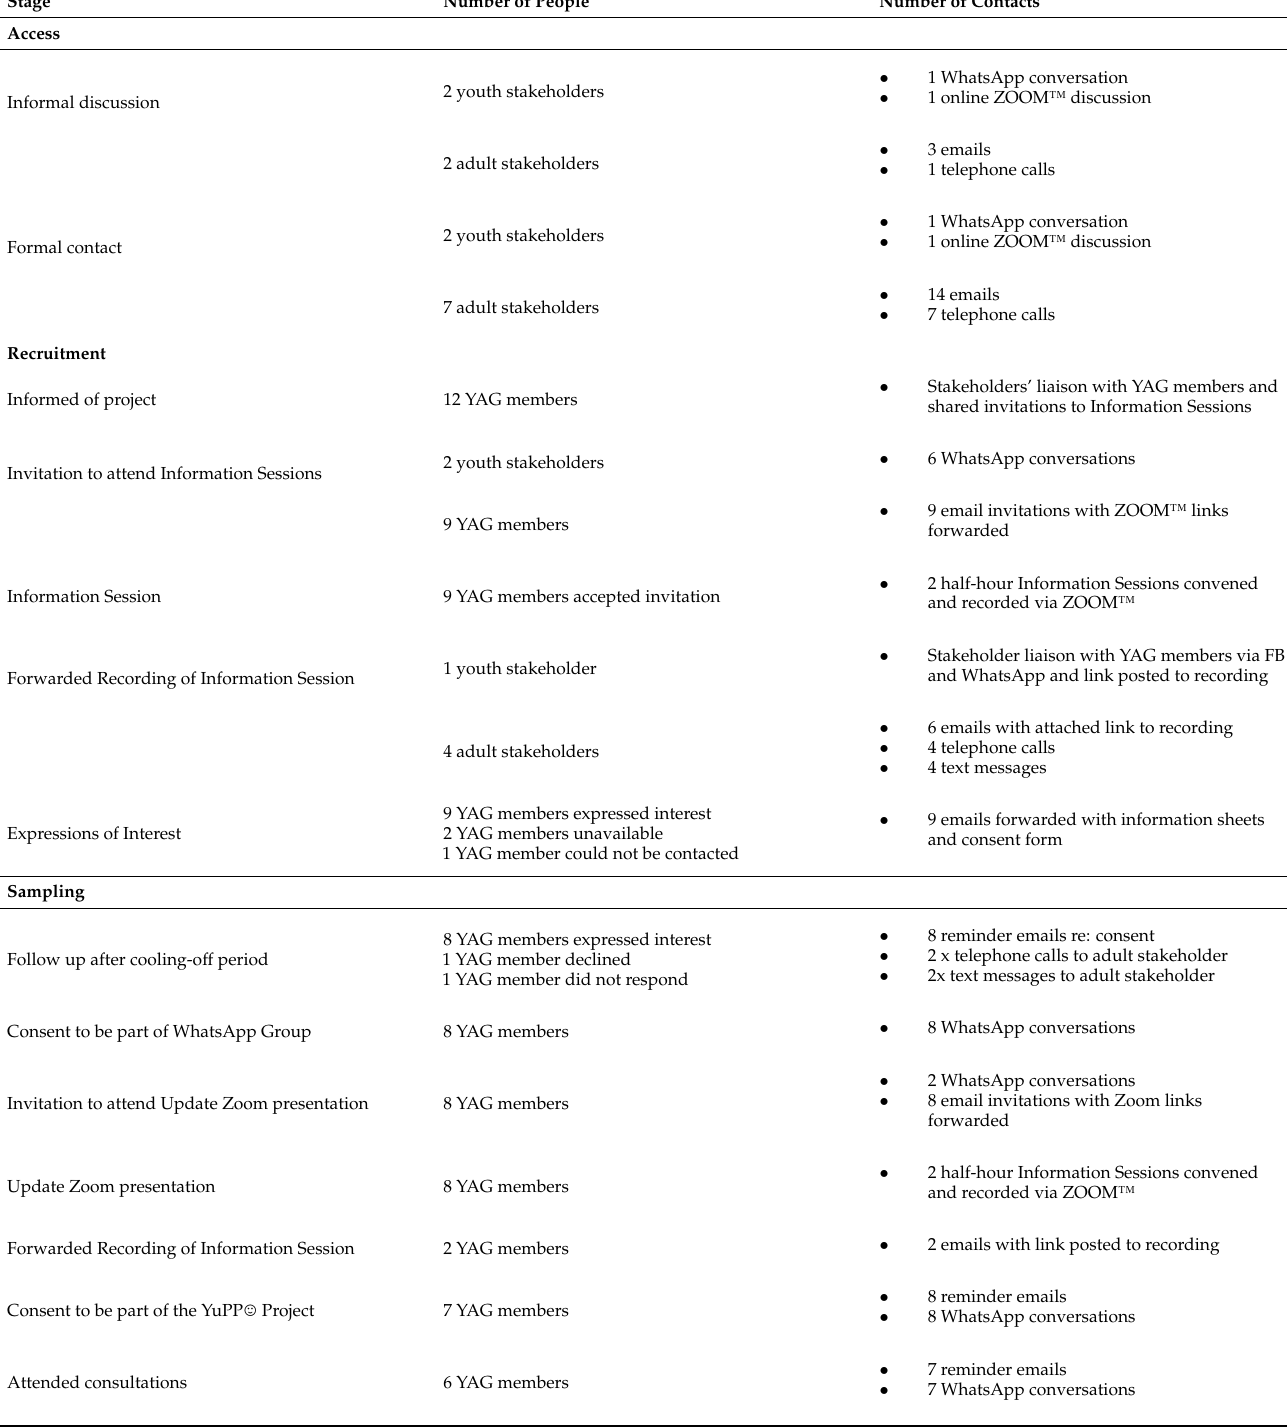
Table 1. Access, recruitment and sampling approach for involving LGBT+ youth and peer allies in the